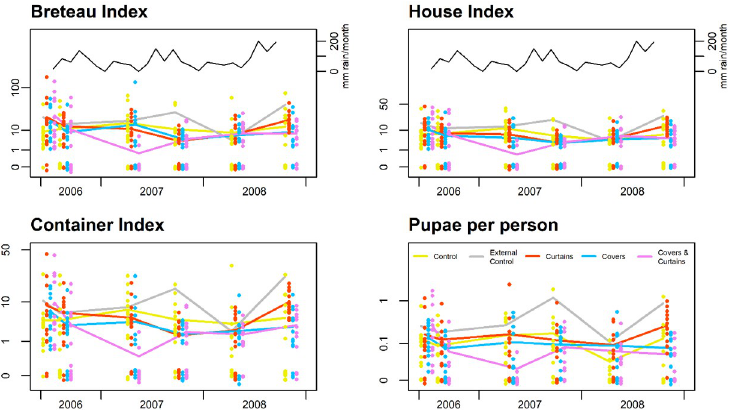
Fig 4. Entomological indices presented by study arm over time. Individual dots represent individual clusters. The lines join the arithmetic means over clusters at each time point. The numerical values are included in S1 Table.